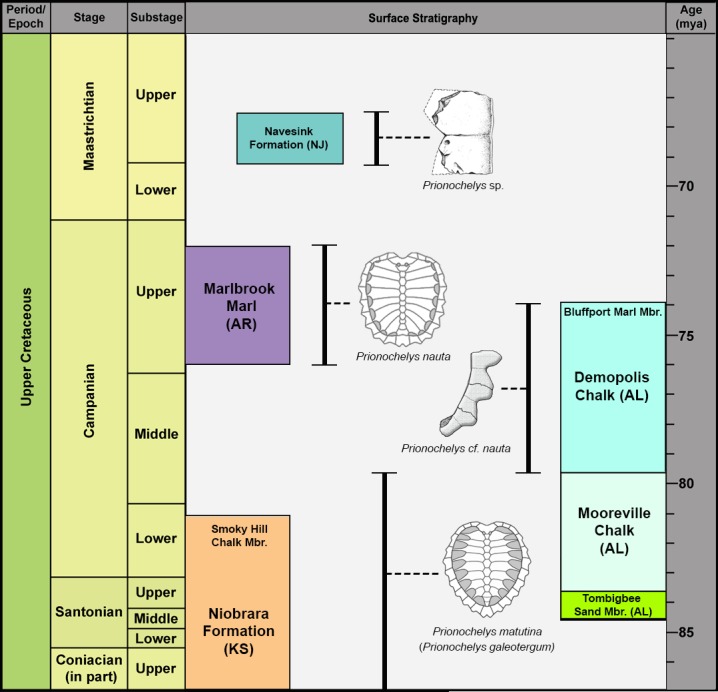
Stratigraphic occurrence of Prionochelys.Illustration of Prionochelys sp. peripheral from Baird & Case (1966).